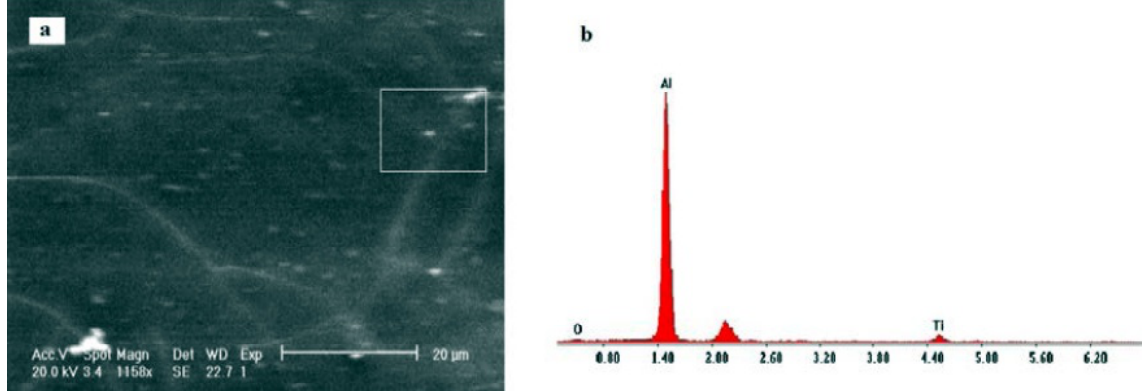
composite (a) the SEM micrograph and (b) the EDS analysis. 2